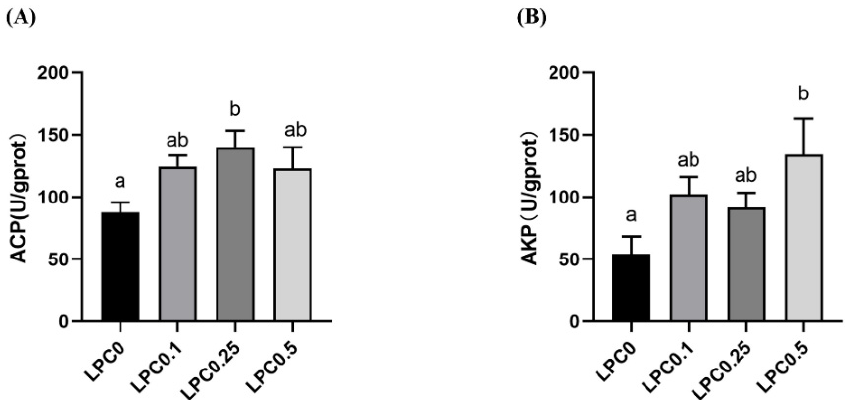
Figure 3. The intestinal enzyme activities of experimental turbot. ( A ) Alkaline Phosphatase (AKP); ( B ) Acid phosphatase (ACP). Results were expressed as means ± S.E., and different superscript letters indicate significant differences ( p < 0.05).